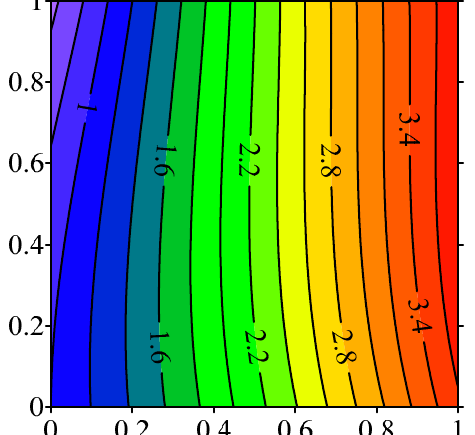
Figure 4. TDdistribution of numerical solutions in Case 1.